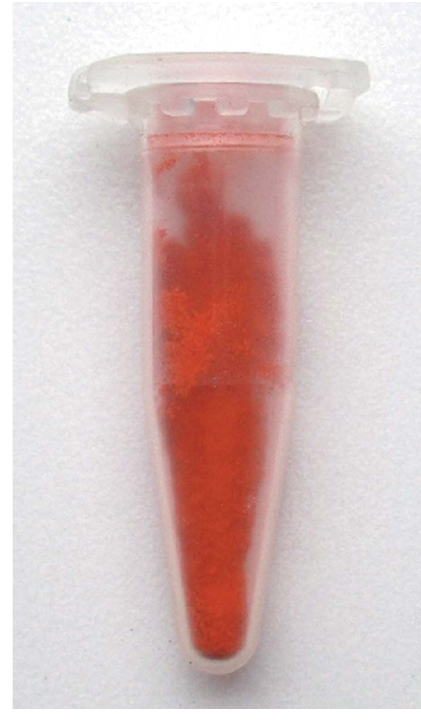
Figure 8 Colour of 4,11-DFQ.